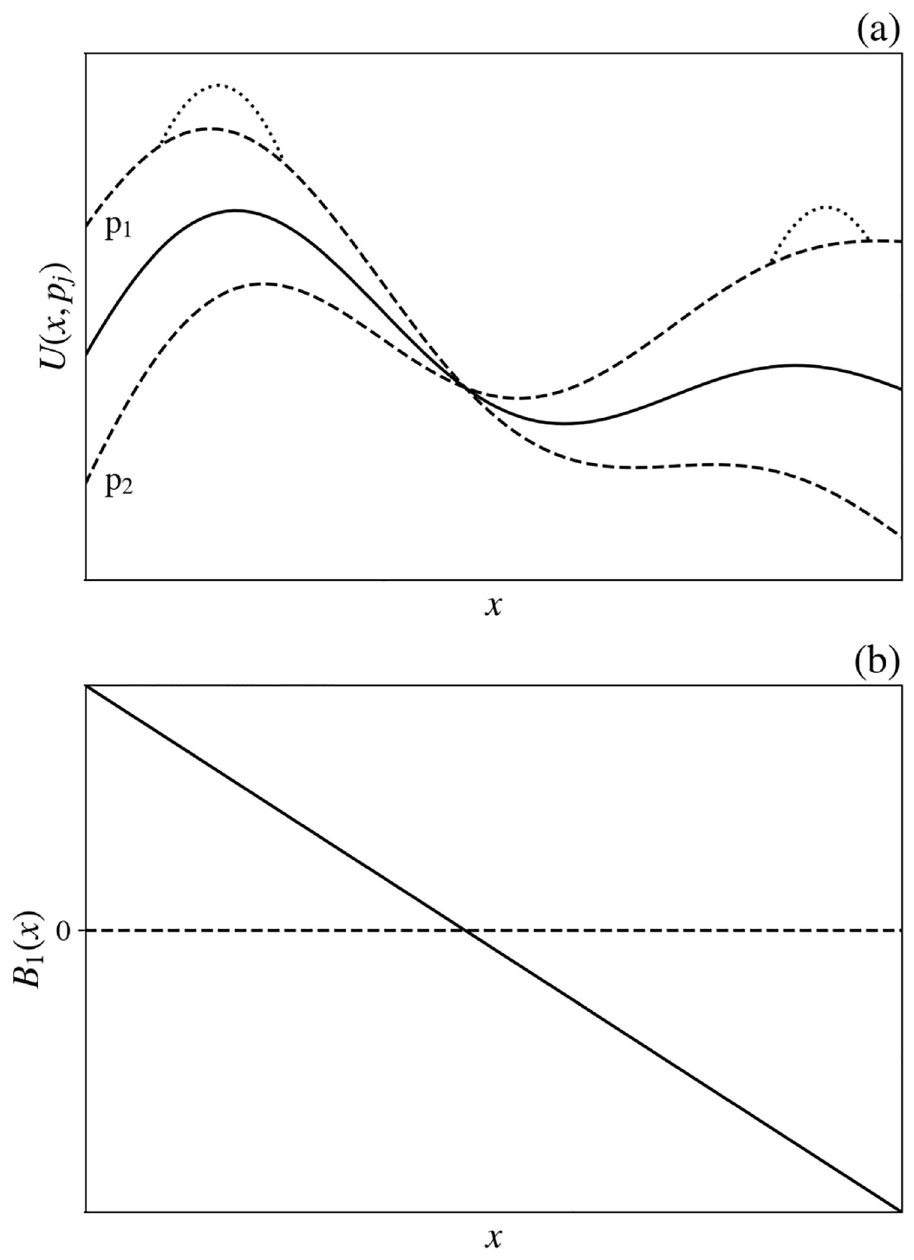
Fig 2. Schematic utility function U vs. dwelling position x , shown as one-dimensional for simplicity. (a) U 0 ( x ) is shown solid along with U ( x , p 1 ) and U ( x , p 2 ) (dashed) from Eq (4) for two households p 1 and p 2 with s 1 ( p 1 ) = 1 and s 1 ( p 2 ) = − 1, to indicate like or dislike of characteristic B 1 , respectively. All other elements of the preference vectors are equal to zero. Dotted curves indicate the change in U ( x , p ) if people of similar preference cluster near their utility j maximum. (b) Spatial variation B 1 ( x ) vs. x